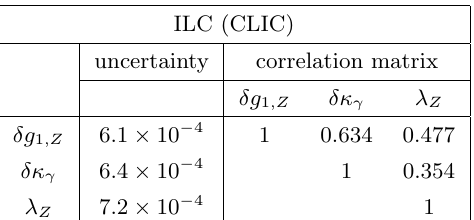
measurements at ILC (cid:0) ! WW + ) = ( 0 : 8 ; 0 : 3) beam (cid:0) ; e (cid:6) (cid:6)